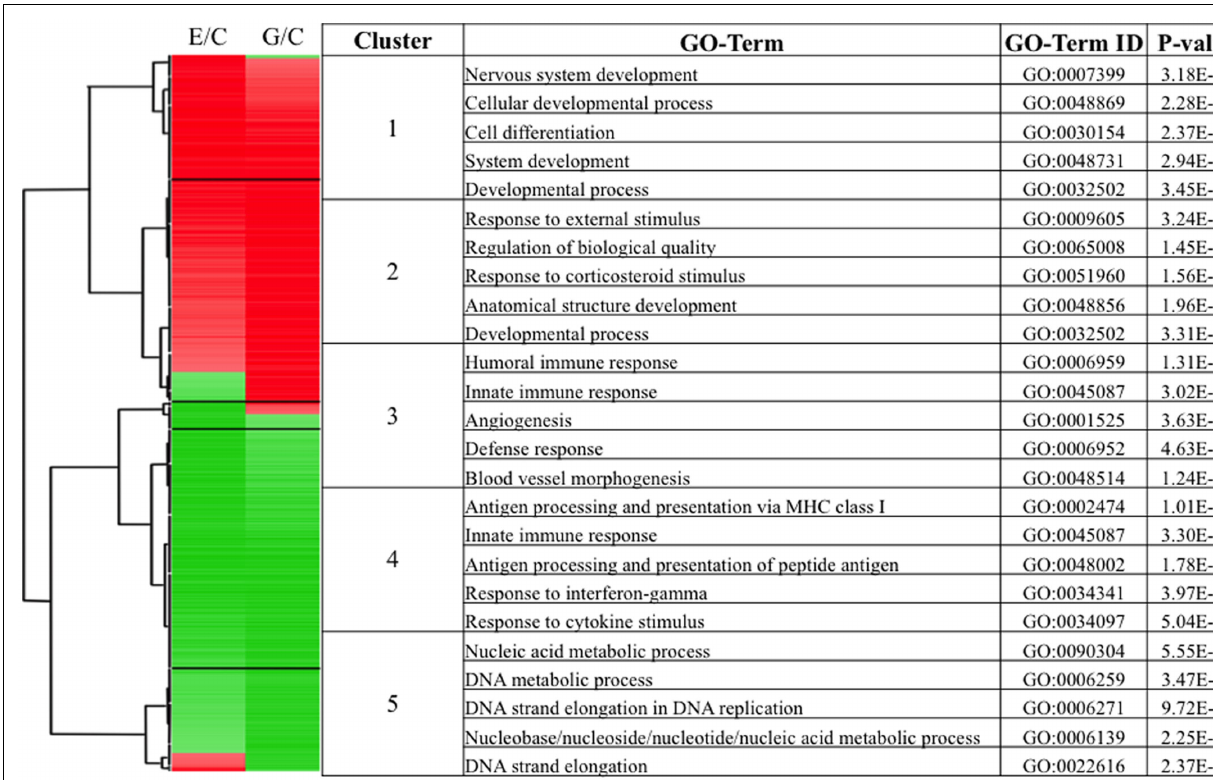
distinct clusters are indicated, with the direction (red, increased; green, decreased) and magnitude of change (color intensity) indicated (left-hand portion).The top biological processes most enriched in each of the five clusters (along with corresponding GO ID terms and p values) are presented (right-hand